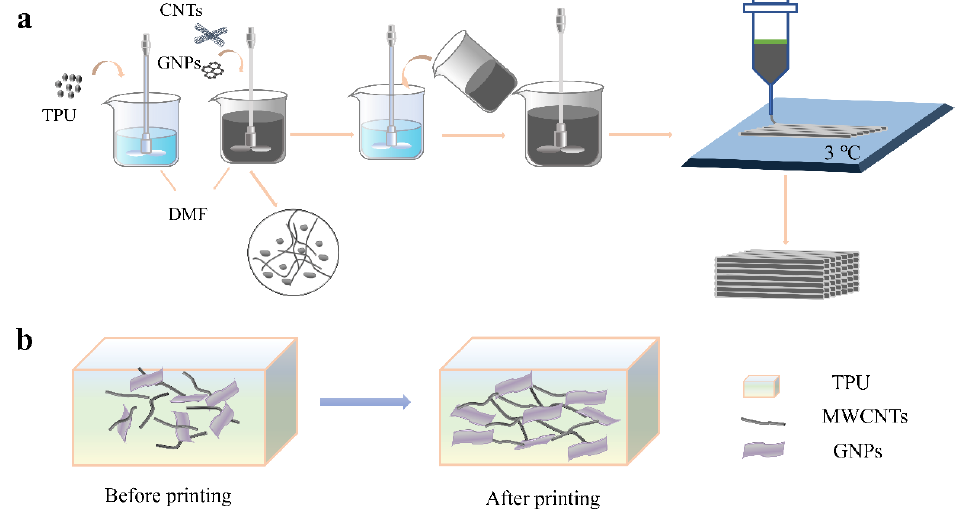
Figure 1. ( a ) Ink formulation and DIW forming process. ( b ) Schematic diagram of the filler arrange- ment mechanism inside the polymer matrix.